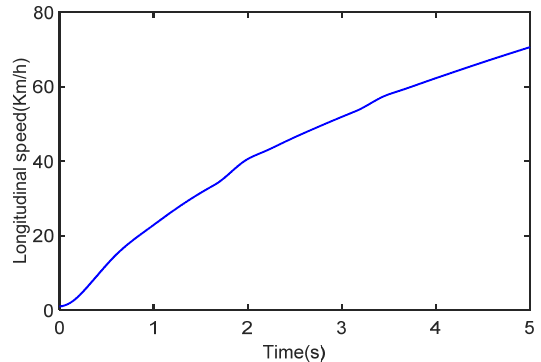
Figure 4. The vehicle speed in the case of acceleration.